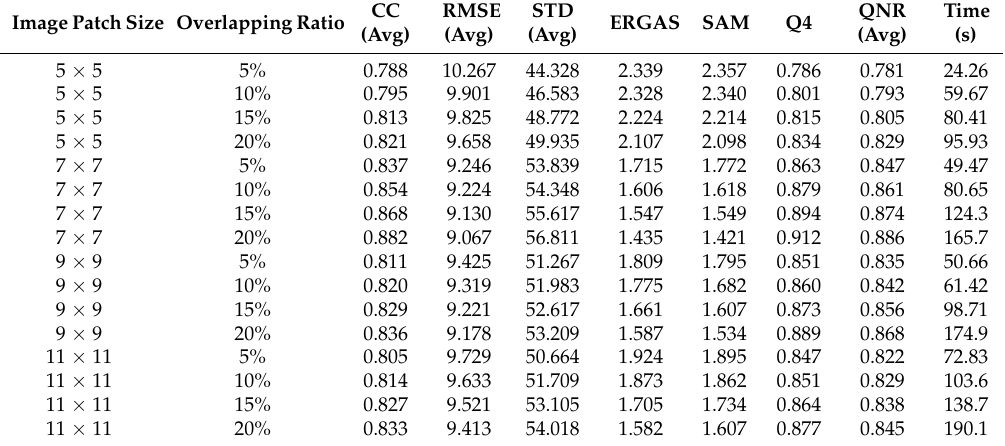
Table 7. Impact of image patch size and overlapping ratio on Pleiades-1A image. Image Patch Size Overlapping Ratio